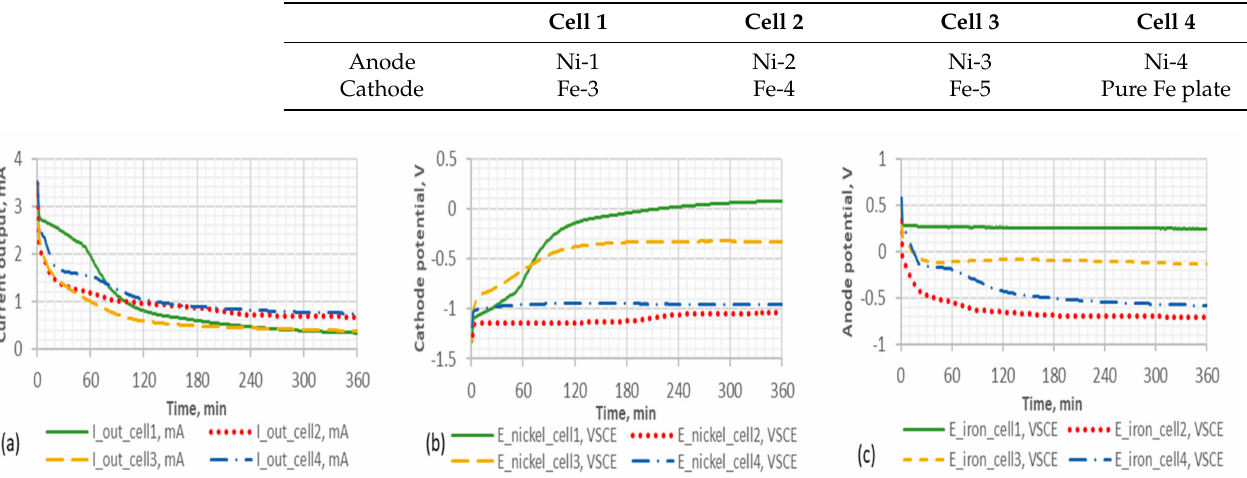
Figure 6. Current and potential profiles of the powder-mixing electrodes through a 500 Ω resistor for each cell. The aarrangements of the cells are listed in Table 10. Subfigure ( a ) represents the current profile, ( b ) for the cathode profile and ( c ) for the anode profile.